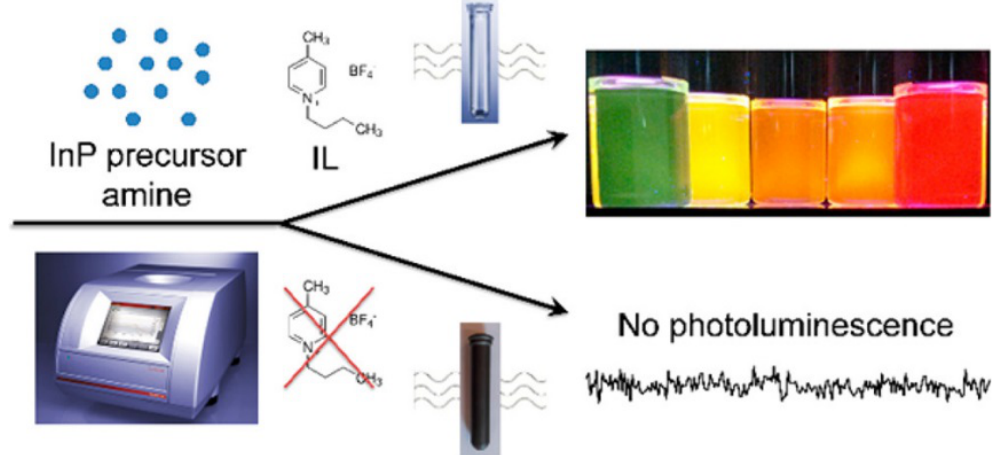
Figure 7. Scheme of microwave-assisted synthesis of InP nanocrystals in ionic liquid (IL) with color-tunable luminescence [77].Copyright American Chemical Society, 2017.